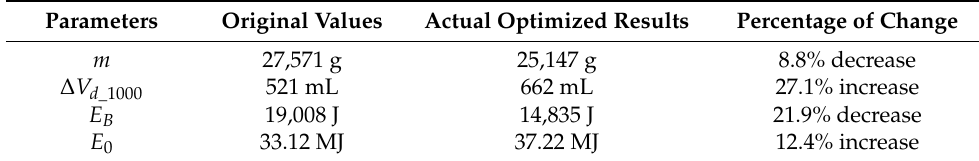
Table 6. The actual optimization results of the performance parameters.